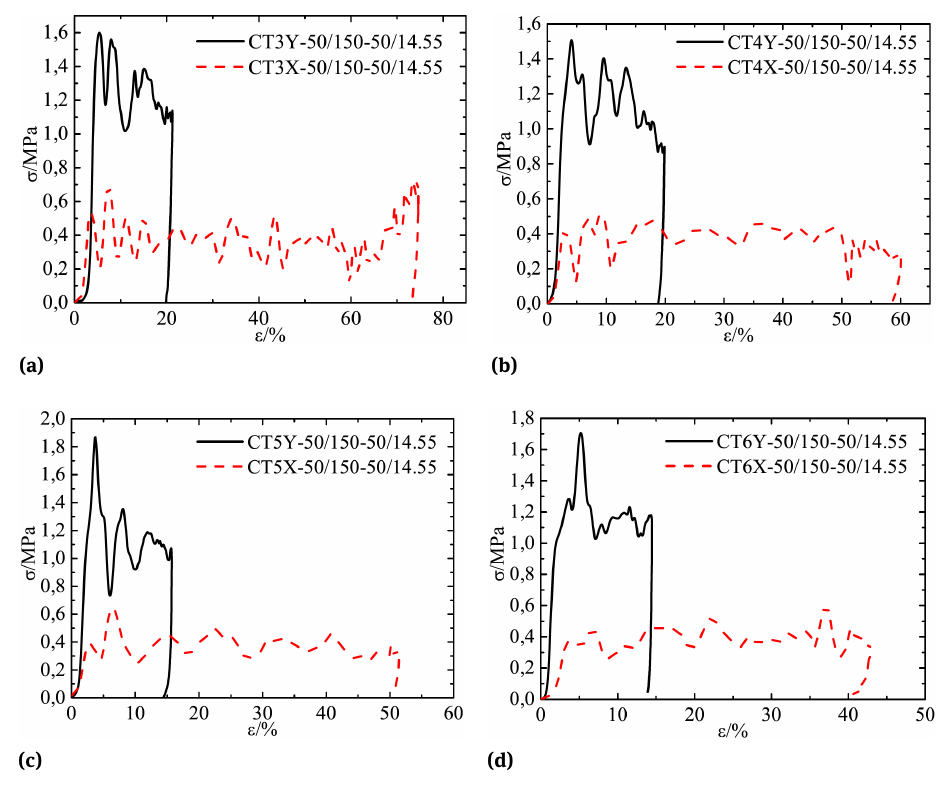
Figure 3: Dynamic stress and strain curves for different tube directions: (a) triangle, (b) quadrangle, (c) pentagon and (d) hexagon